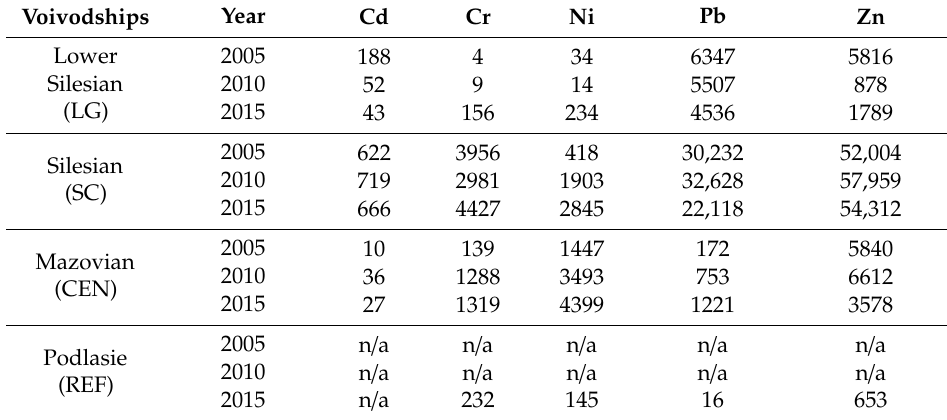
Table 3. Atmospheric emissions of trace metals (kg year − 1 ) in 2005, 2010, and 2015 from industrial plants that are particularly harmful to the environment for voivodships most overlapping with the surveyed regions. Data obtained from Statistics Poland